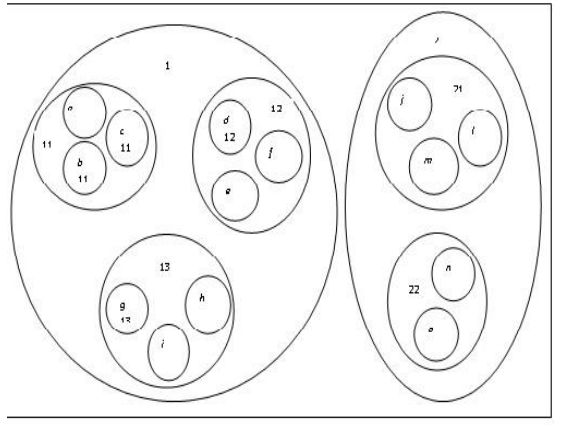
Figure 1. DST with nodes and names